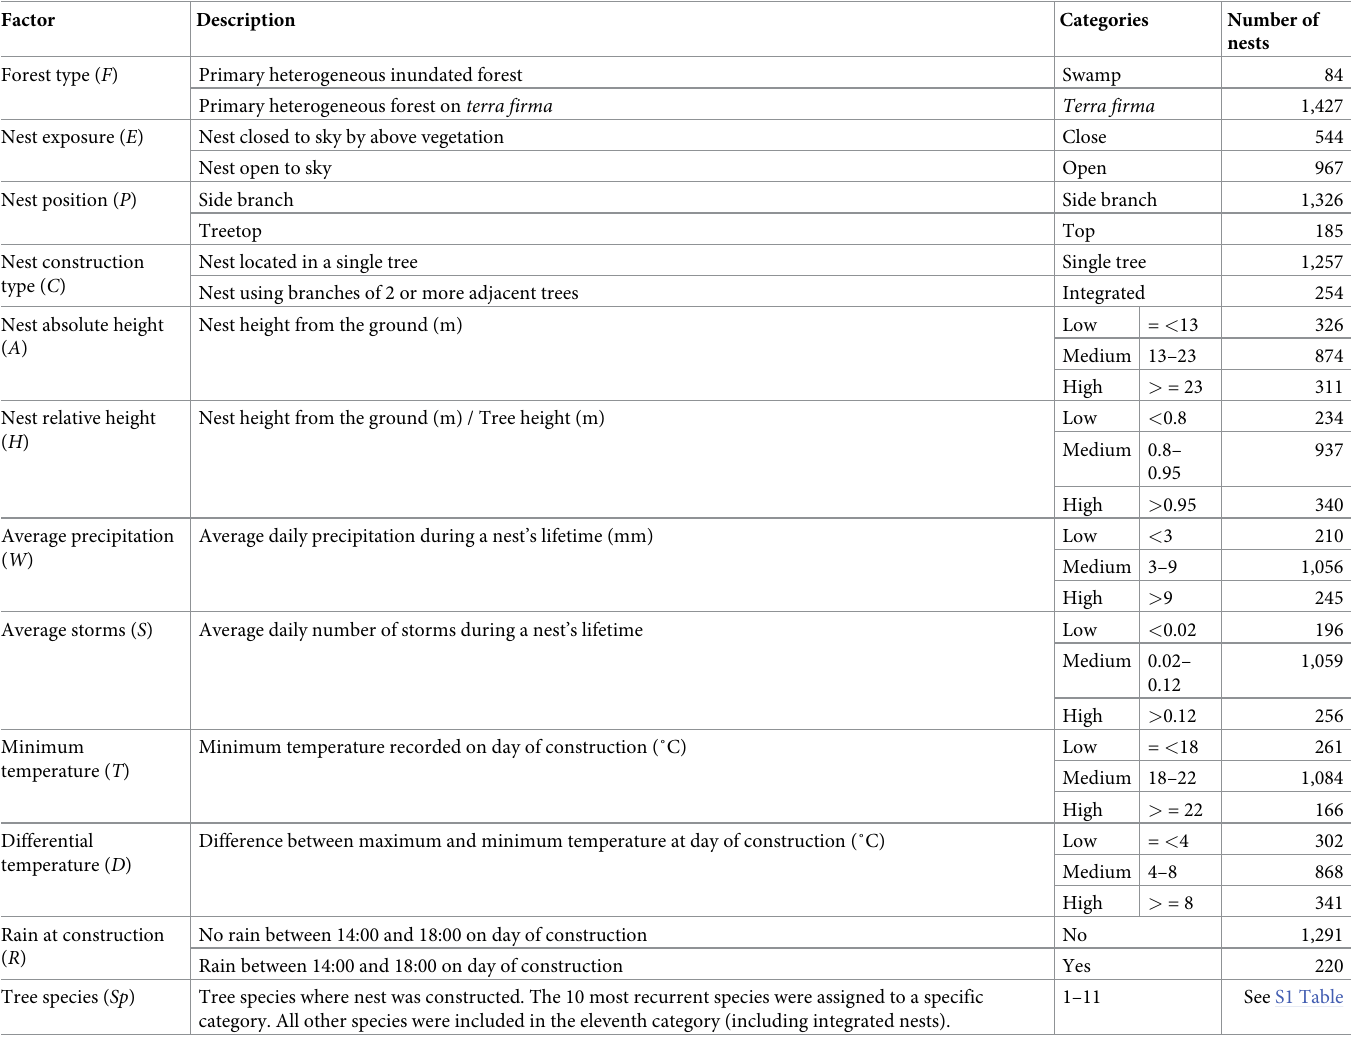
Table 1. Nest type categories definitions, and sample sizes used in this study.